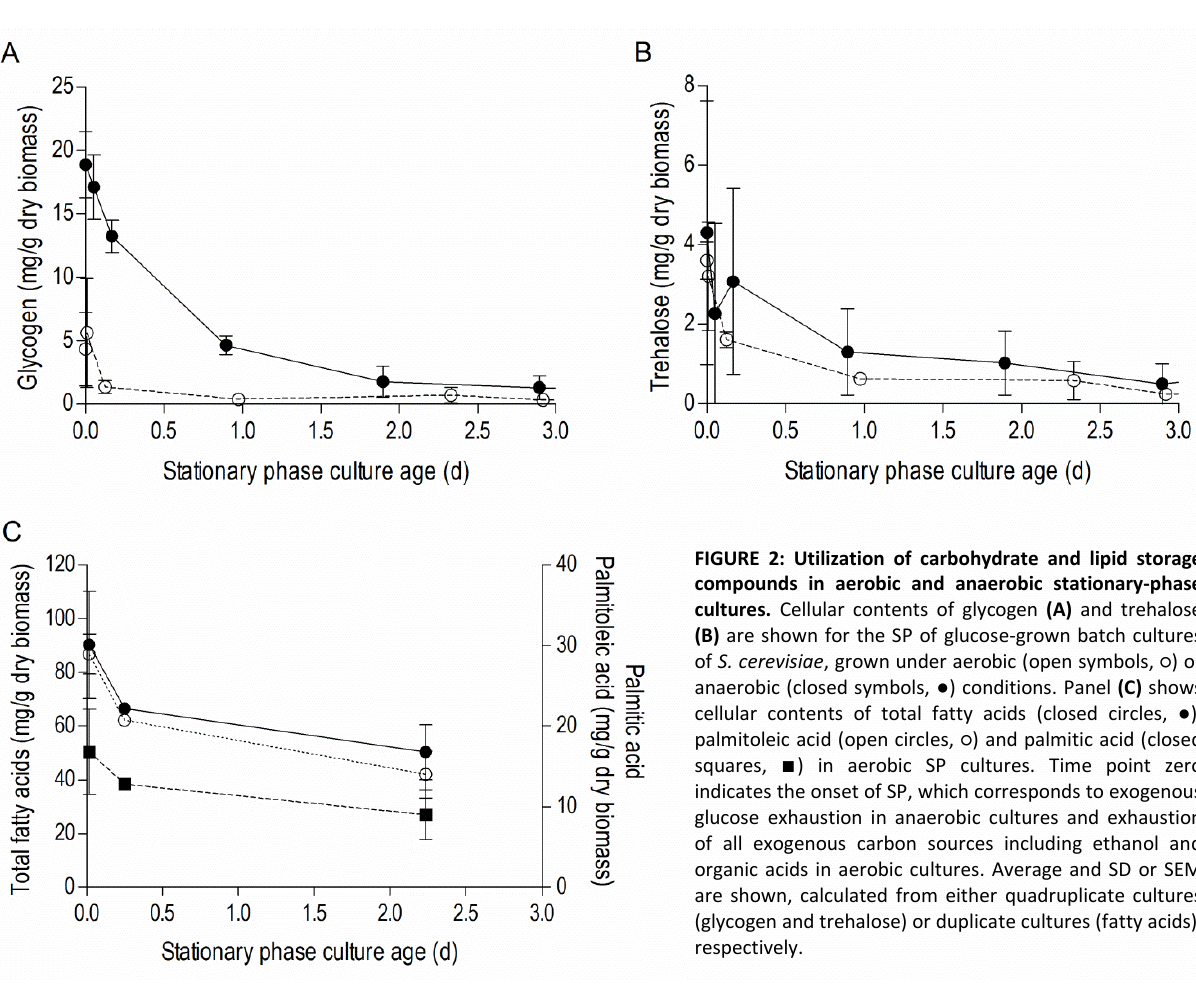
FIGURE 2: Utilization of carbohydrate and lipid storage compounds in aerobic and anaerobic stationary-phase cultures. Cellular contents of glycogen (A) and trehalose (B) are shown for the SP of glucose-grown batch cultures of S. cerevisiae , grown under aerobic (open symbols, ○) or anaerobic (closed symbols, ●) conditions. Panel (C) shows cellular contents of total fatty acids (closed circles, ●), palmitoleic acid (open circles, ○) and palmitic acid (closed squares, ∎ ) in aerobic SP cultures. Time point zero indicates the onset of SP, which corresponds to exogenous glucose exhaustion in anaerobic cultures and exhaustion of all exogenous carbon sources including ethanol and organic acids in aerobic cultures. Average and SD or SEM are shown, calculated from either quadruplicate cultures (glycogen and trehalose) or duplicate cultures (fatty acids),